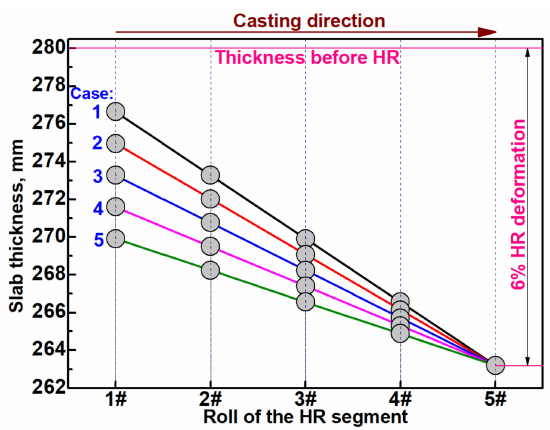
Figure 17. Variation of the slab thickness within the HR segment in Case 1 to